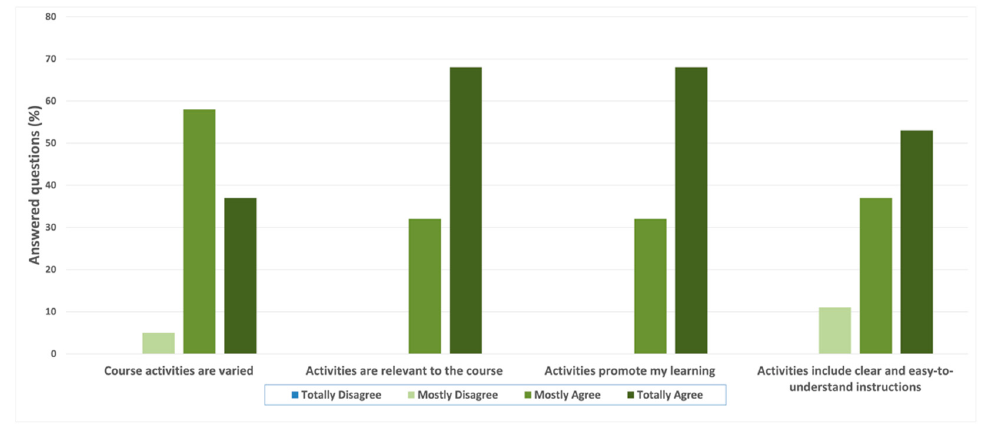
Figure 3. Participant’s answers to Question #2—“Indicate your level of agreement with the following statements about the activities (tests, tasks) of the course.”